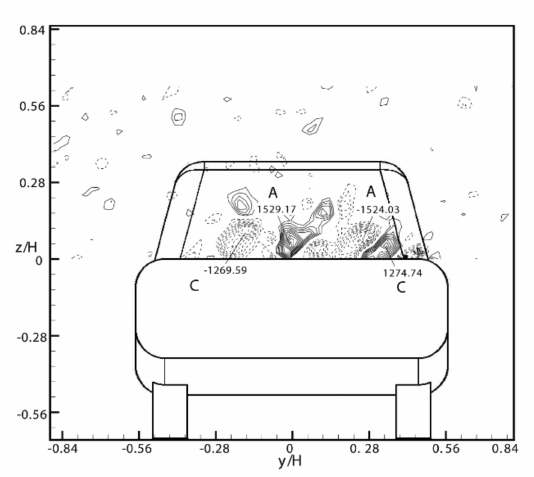
Figure 13. Iso-contours of instantaneous streamwise vorticity ω x in y–z plane at x/H = − 0.11. Minimum and incremental values of vorticity are ω x,min = − 251.859 s − 1 , 257.007 s − 1 , and − 1 , ∆ ω x = 141.352 s